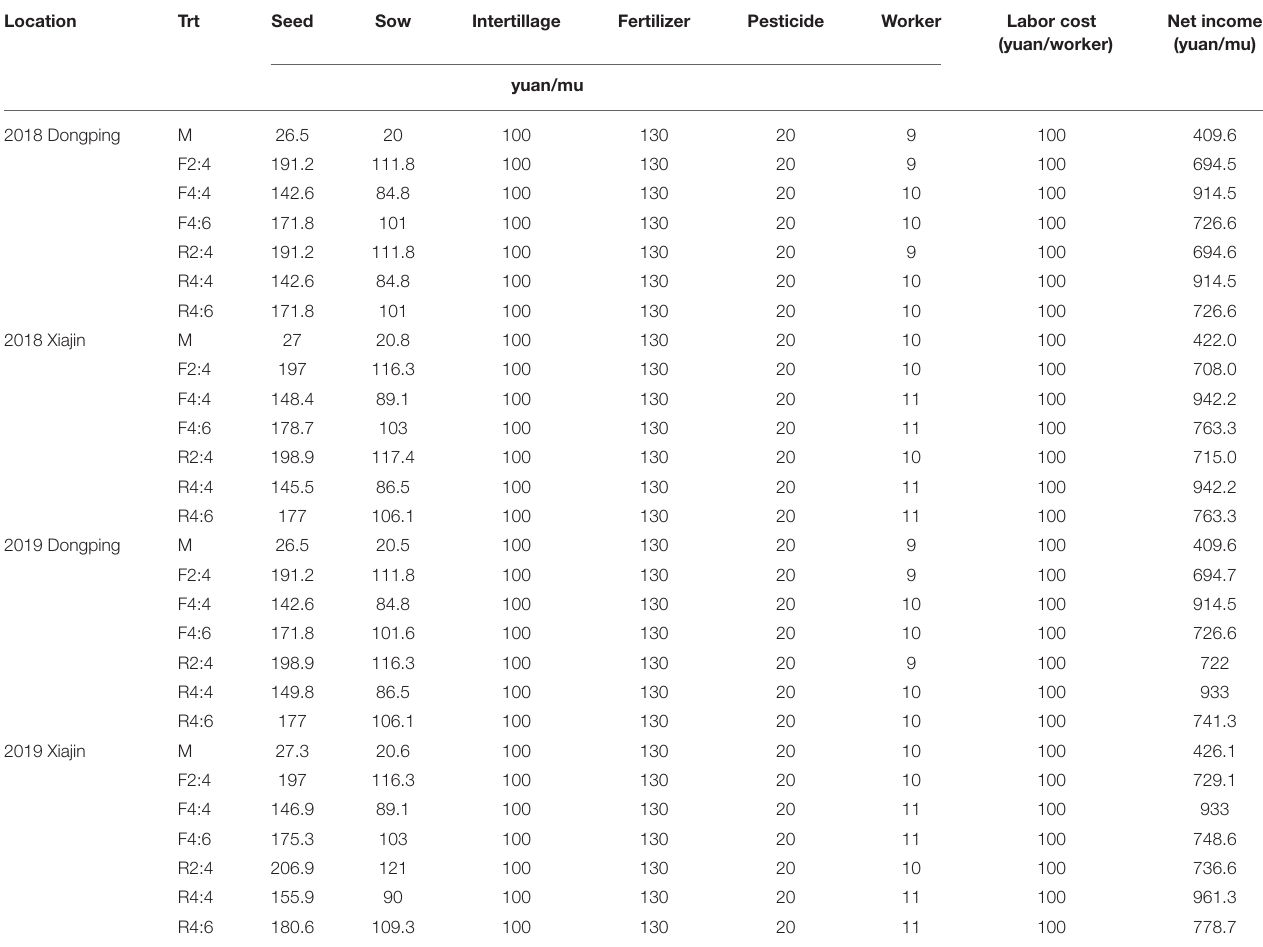
TABLE 5 | Cost and benefit of cotton production in 2018 and 2019. Location Trt Seed Sow Intertillage Fertilizer Pesticide Worker Labor cost